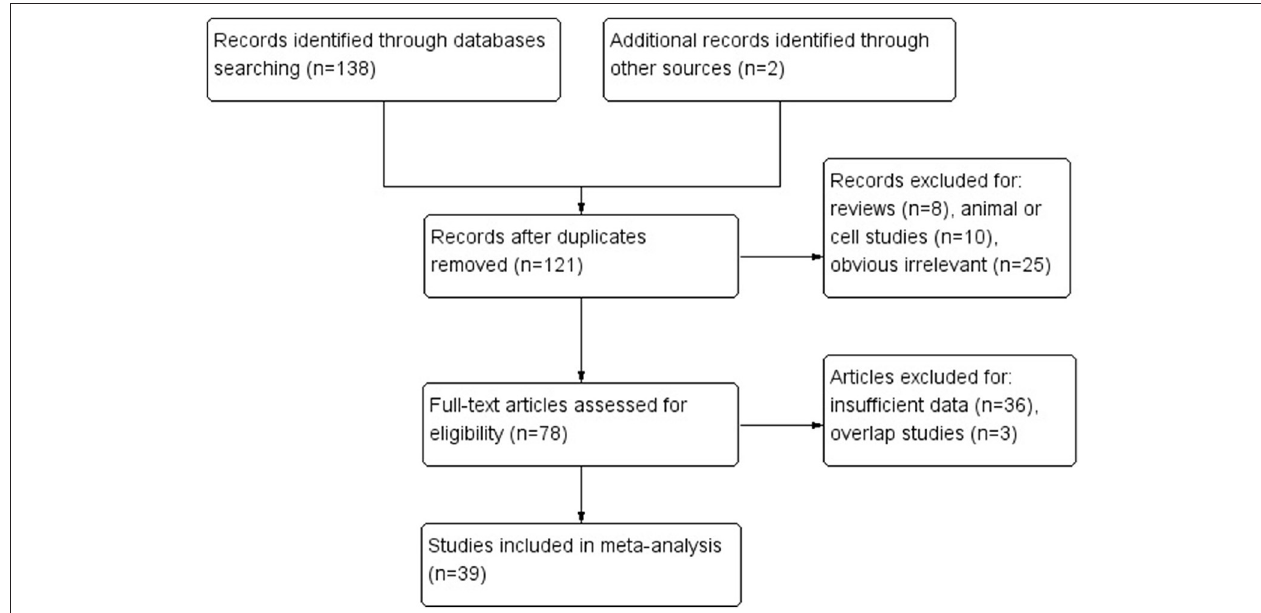
FIGURE 1 | Flow diagram of literature selection.